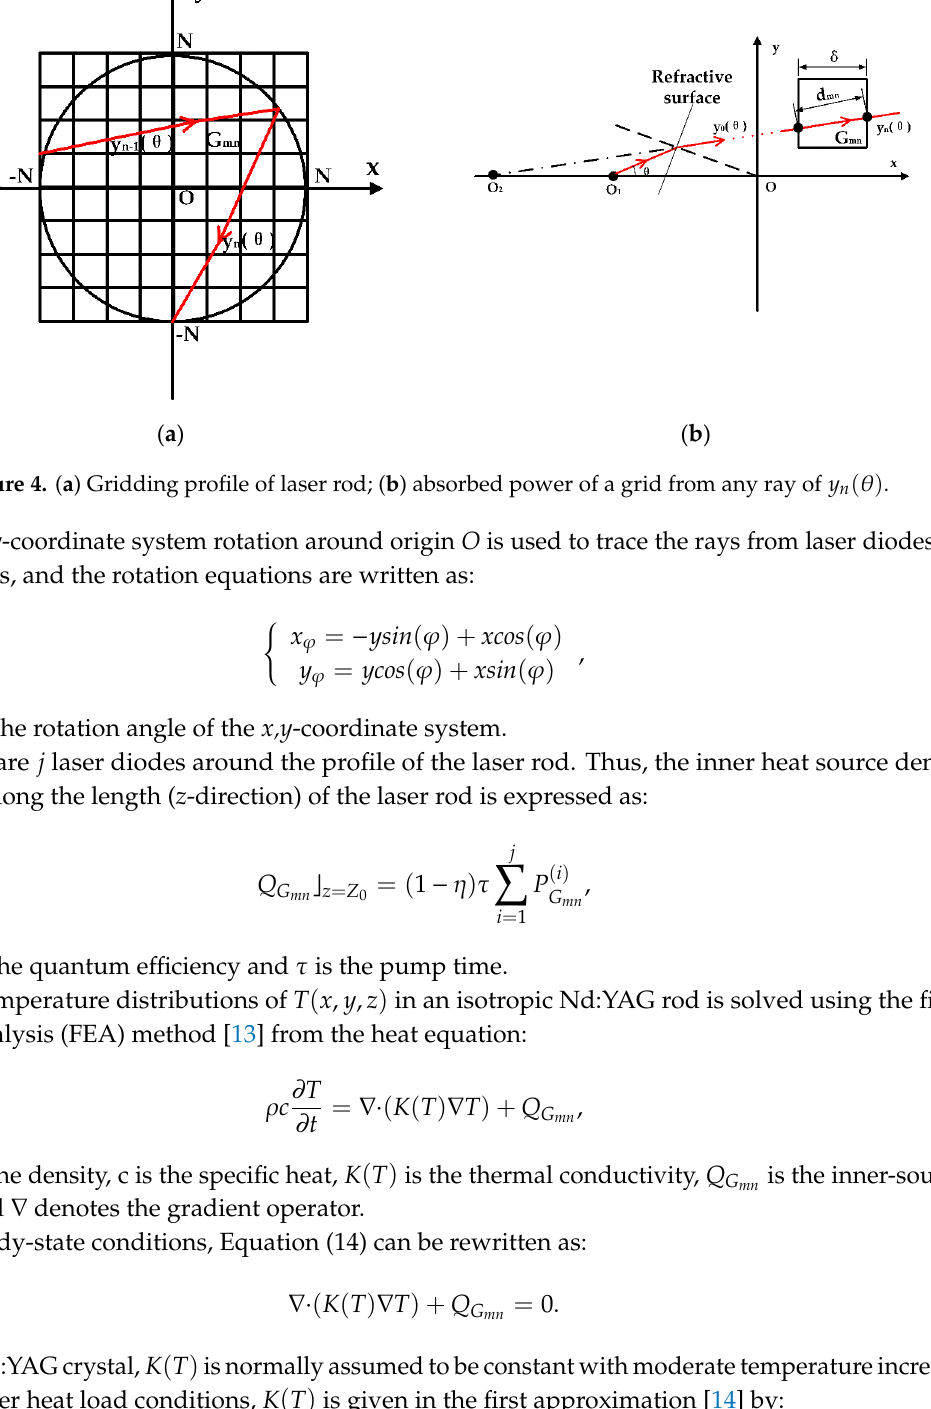
Figure 3. Schematic of ray-tracing.